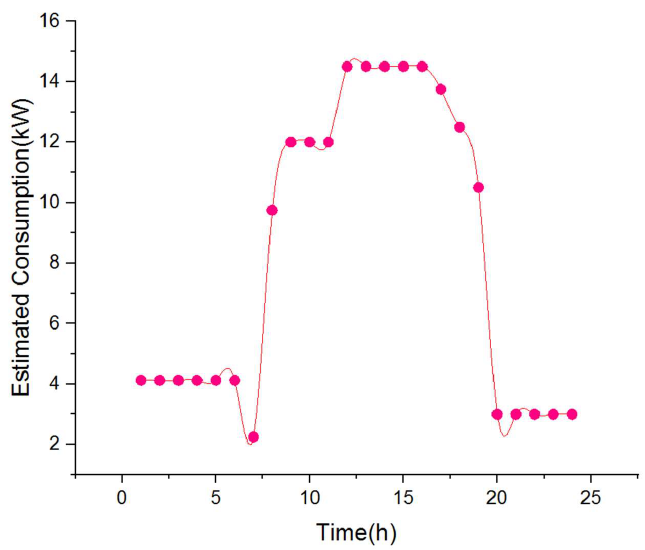
Figure 2. Simulated load profile for a rural area.